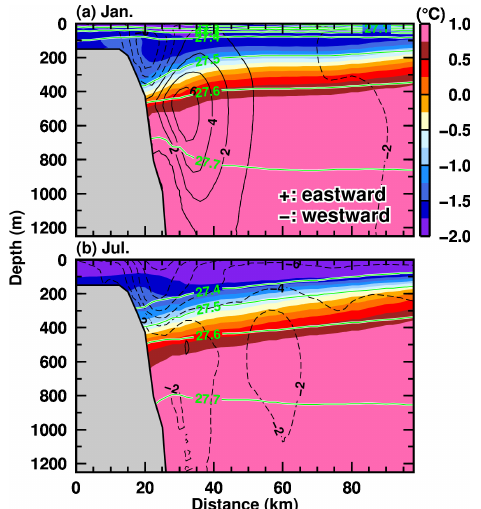
Figure 18. Vertical profiles of potential temperature (color), poten- tial density anomaly (green contours), and east–west velocity (black contours) along the north–south section at 35.75 ◦ E (see the black line in Fig. 17) in (a) January and (b) July in the NOFI case. Positive and negative values of the velocity indicate eastward and westward, respectively. The variables were averaged over the period 2008– 2018.